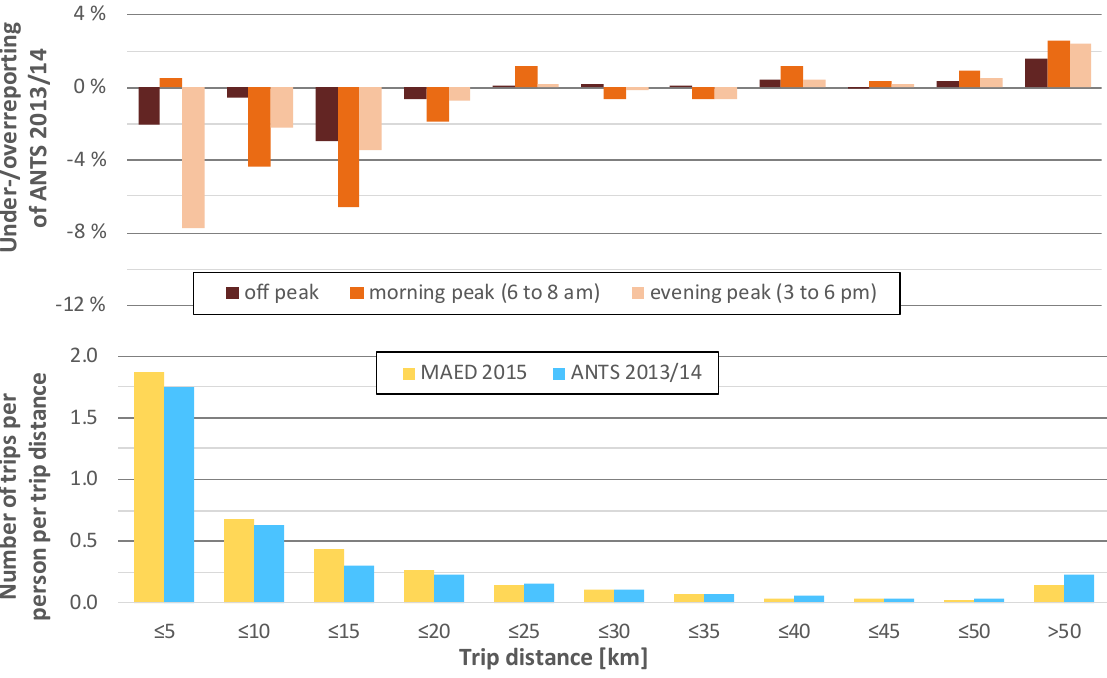
Figure 4. Distribution of trip distances of all trips per person per day (below) and respective under- /overreporting of ANTS 2013/14 (above).